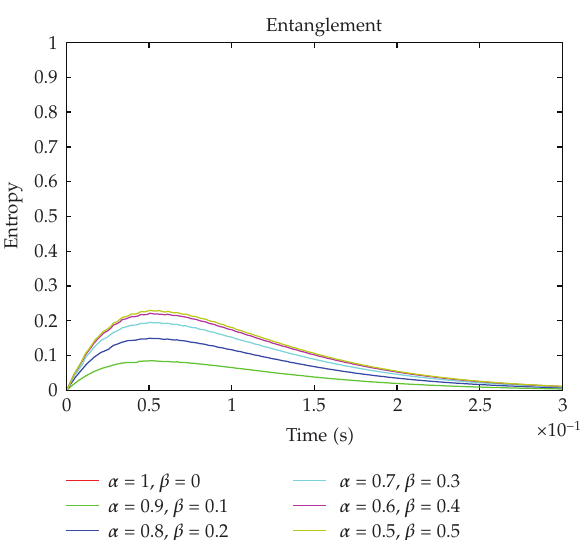
Figure 19: Spin-photon entanglement dynamics for large Δ .